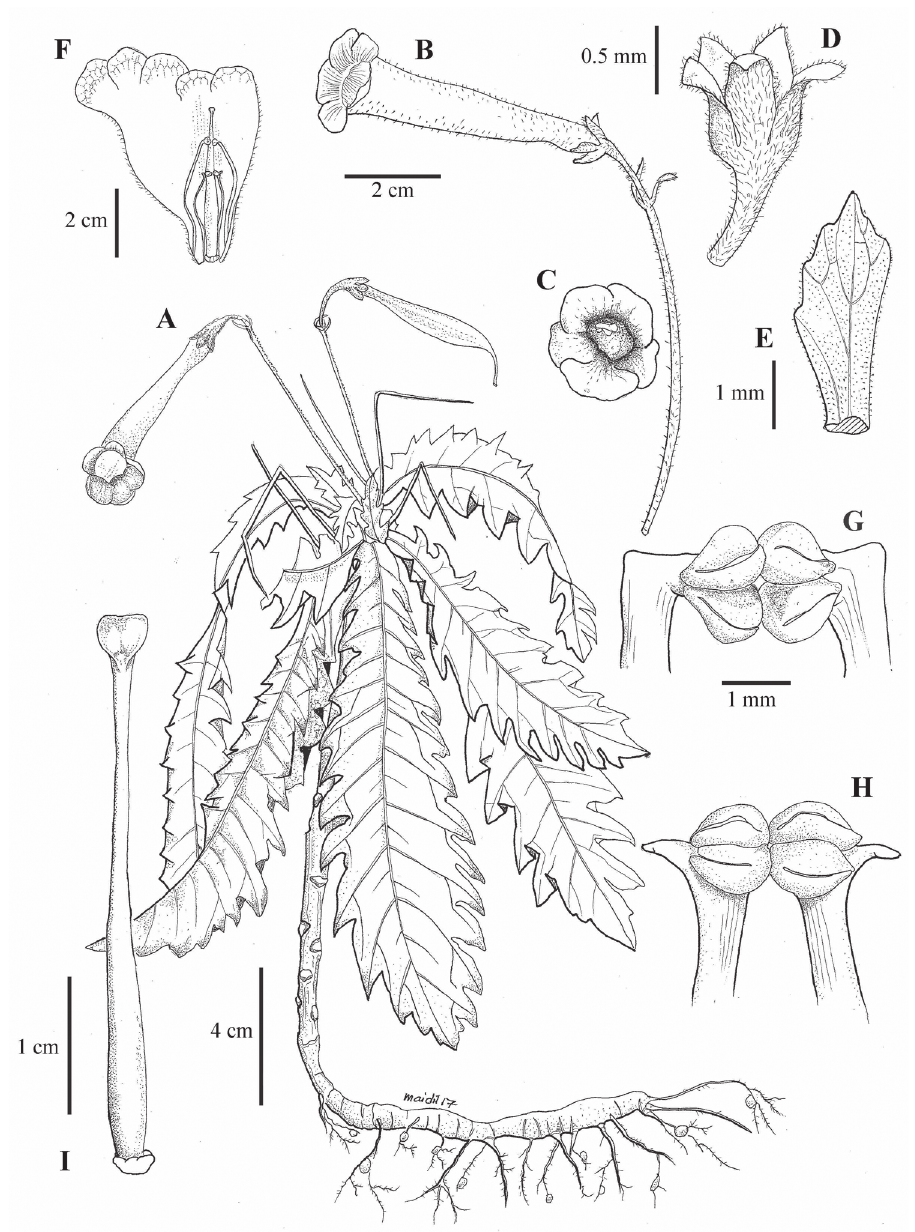
Figure 3. Ridleyandra merohmerea Siti Munirah & Zaharil. A habit with flower and fruit B flower C corolla (front view) D calyx (sepals) E bract F corolla opened to show position of stamen G anthers (upper pair) H anthers (lower pair) I pistil All from Siti Munirah FRI 76345. DRAWN BY M.